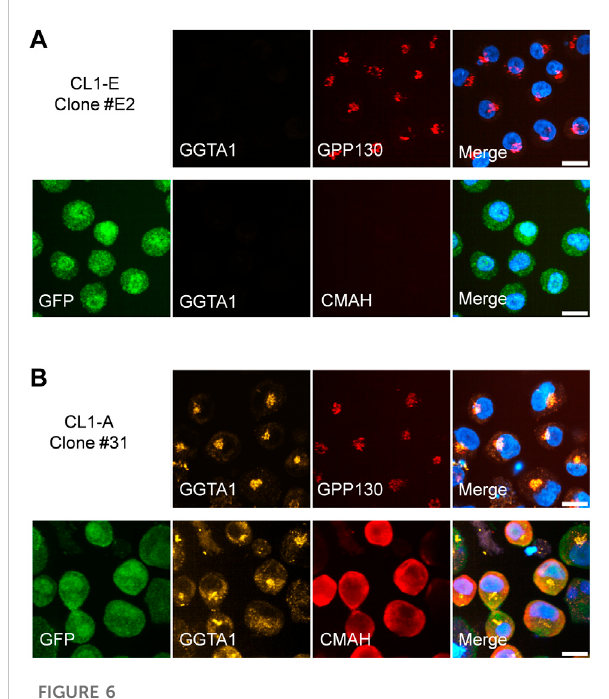
FIGURE 6 Localization of exogenous GGTA1 and CMAH in stably transfected clones. (A) CL1-E clone #E2 shows only the presence of GFP. Top row: staining with mouse monoclonal anti-FLAG M2 and rabbit polyclonal anti-GPP130 detects GPP130 but not FLAG- GGTA1. Bottom row: additional staining with mouse anti-GFP and rabbit monoclonal anti-V5 (instead of anti-GPP130) detects GFP but not CMAH-V5. (B) Expression of FLAG-GGTA1 and CMAH-V5 is detectedinCL1-Aclone#31.Toprow:ColocalizationofFLAG-GGTA1 and GPP130 is observed. Bottom row: staining for GFP and V5 show strong cytoplasmic localization for most cells. Hoechst was used to visualize cell nuclei in all cases. All scale bars are 10 μ